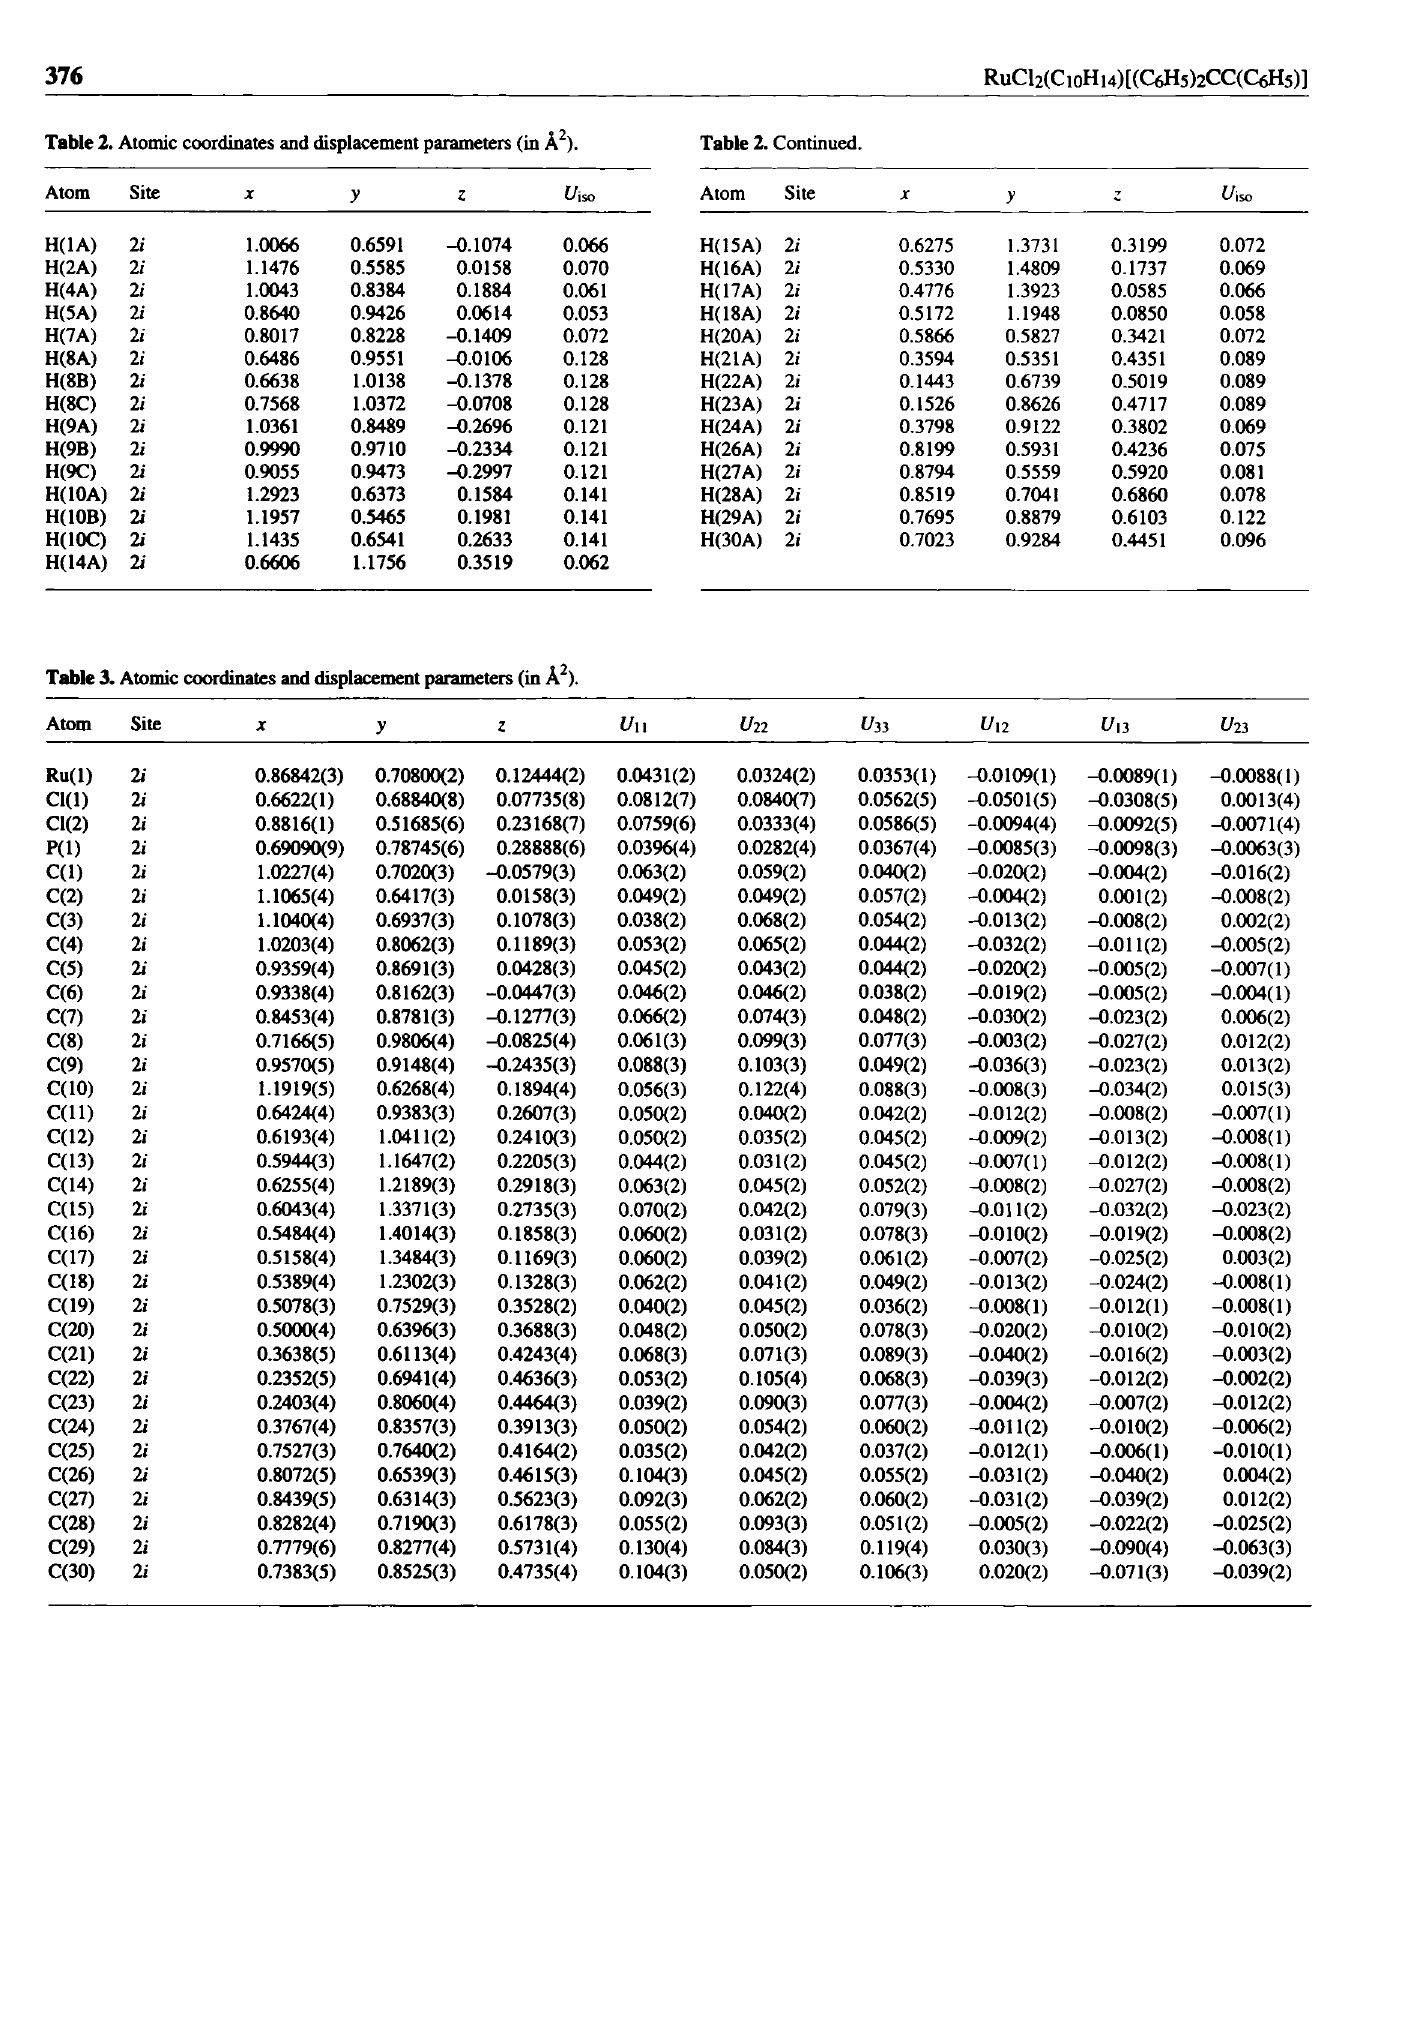
Table 3. Atomic coordinates and displacement parameters (in Â 2